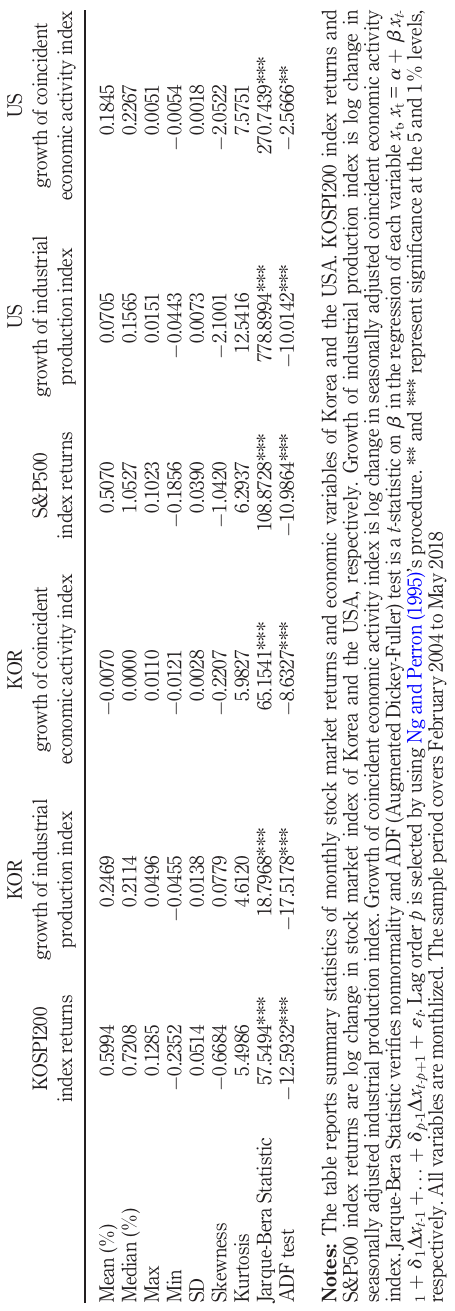
Table 1. Summary